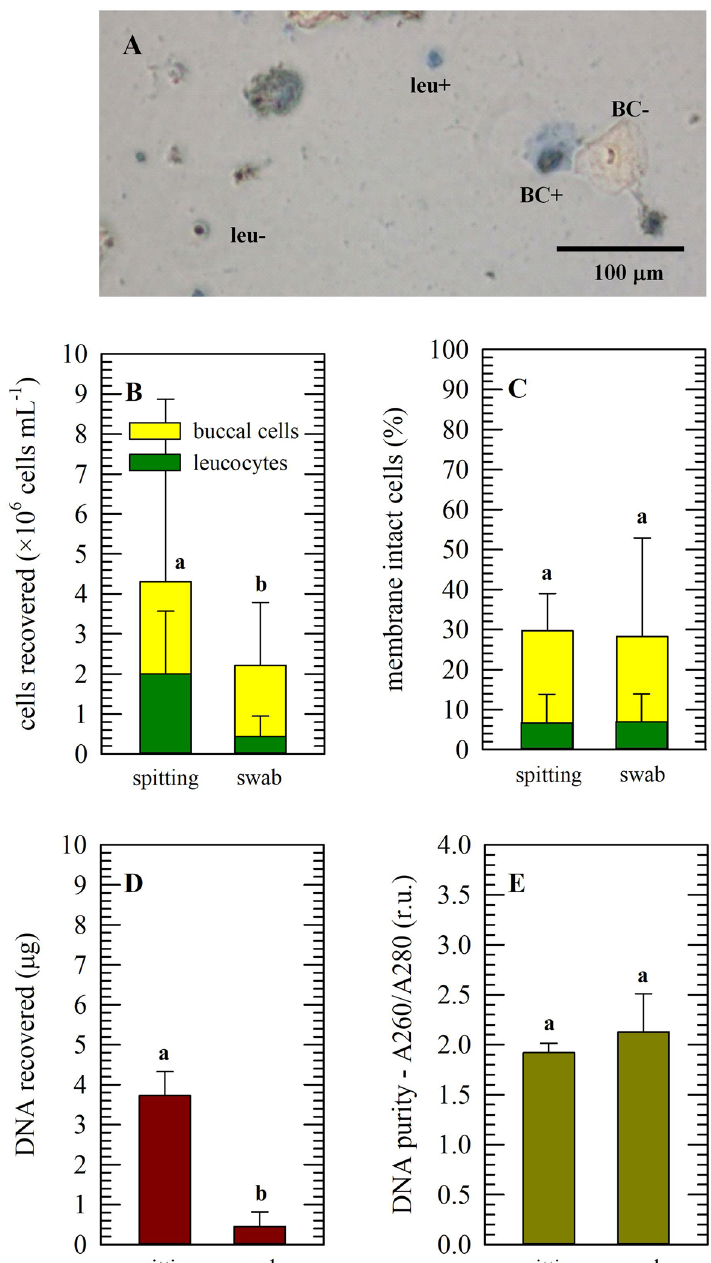
Figure 1. Cell concentration, composition and membrane intactness of saliva samples, as well as DNA contents that were recovered. Saliva (100 µL) was collected via spitting directly in a tube, or via using a buccal swab (2 × 6 × scrubbing) for transfer into saline (100 µL). Microscopic observations of trypan blue stained specimens ( A ) show presence of leukocytes (leu) and buccal cells (BC), whereas membrane damaged cells exhibit intracellular blue staining ( +). Cell concentrations were determined using a hemocytometer ( B ), while also discriminating between numbers of membrane intact/damaged cells ( C ) and cell types (buccal cells: yellow, leucocytes: green). In addition, total DNA was extracted and its content was determined, with respect to the original saliva/saline volumes recovered indicated above ( D ). DNA purity was evaluated by determining the absorbance values at 260 versus 280 nm ( E ). Mean ± standard deviations are presented, originating from saliva samples from twenty different donors, and different letters represent significant differences between collection methods ( p ≤ 0.05) as determined using a student’s